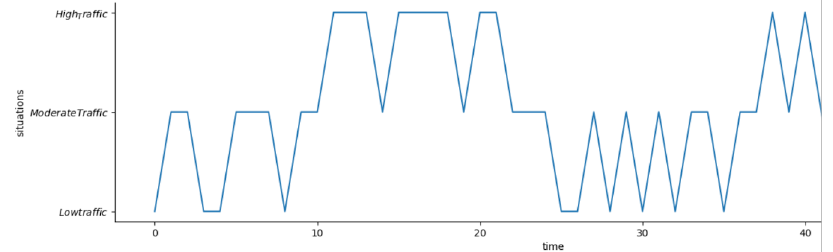
Figure 19. Markov Simulation for Situations in a Traffic Monitoring